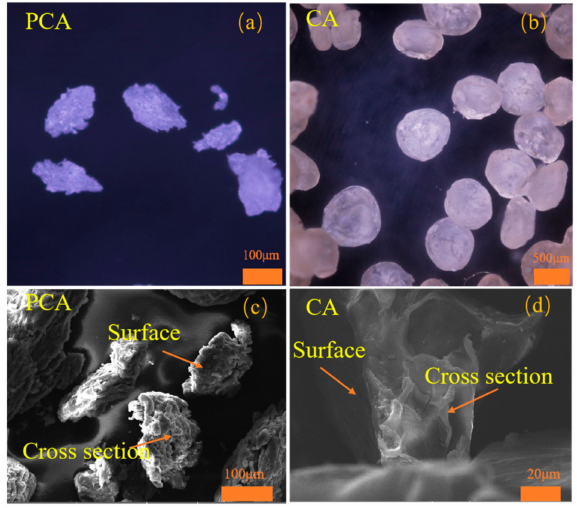
Figure 3. The morphology of PCA and CA: ( a , c ) the morphologies of PCA, ( b , d ) the morphologies of